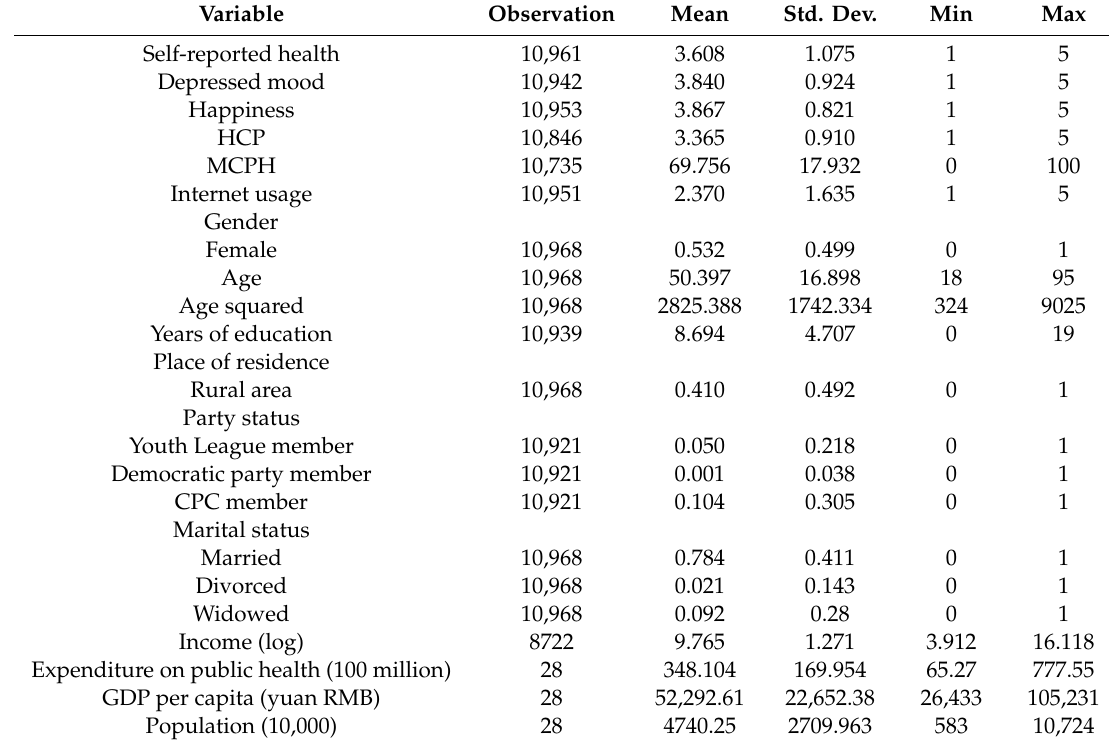
Table 1. Variables